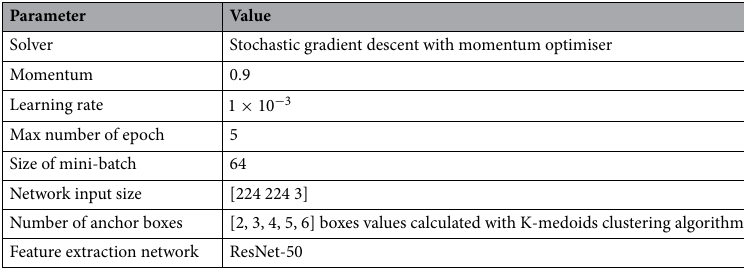
Table 4. Parameter selection used to train the proposed systems. The exact parameters were used to evaluate each detector proposed in this work; this includes numbers and values of anchor boxes, i.e., pre-defined sets of bounding boxes established to capture the scale and aspect ratio of pigs based on their sizes in each class of the training dataset. All image datasets were resized to match the network input size. The parameters were selected using a nested-cross validation with an independent